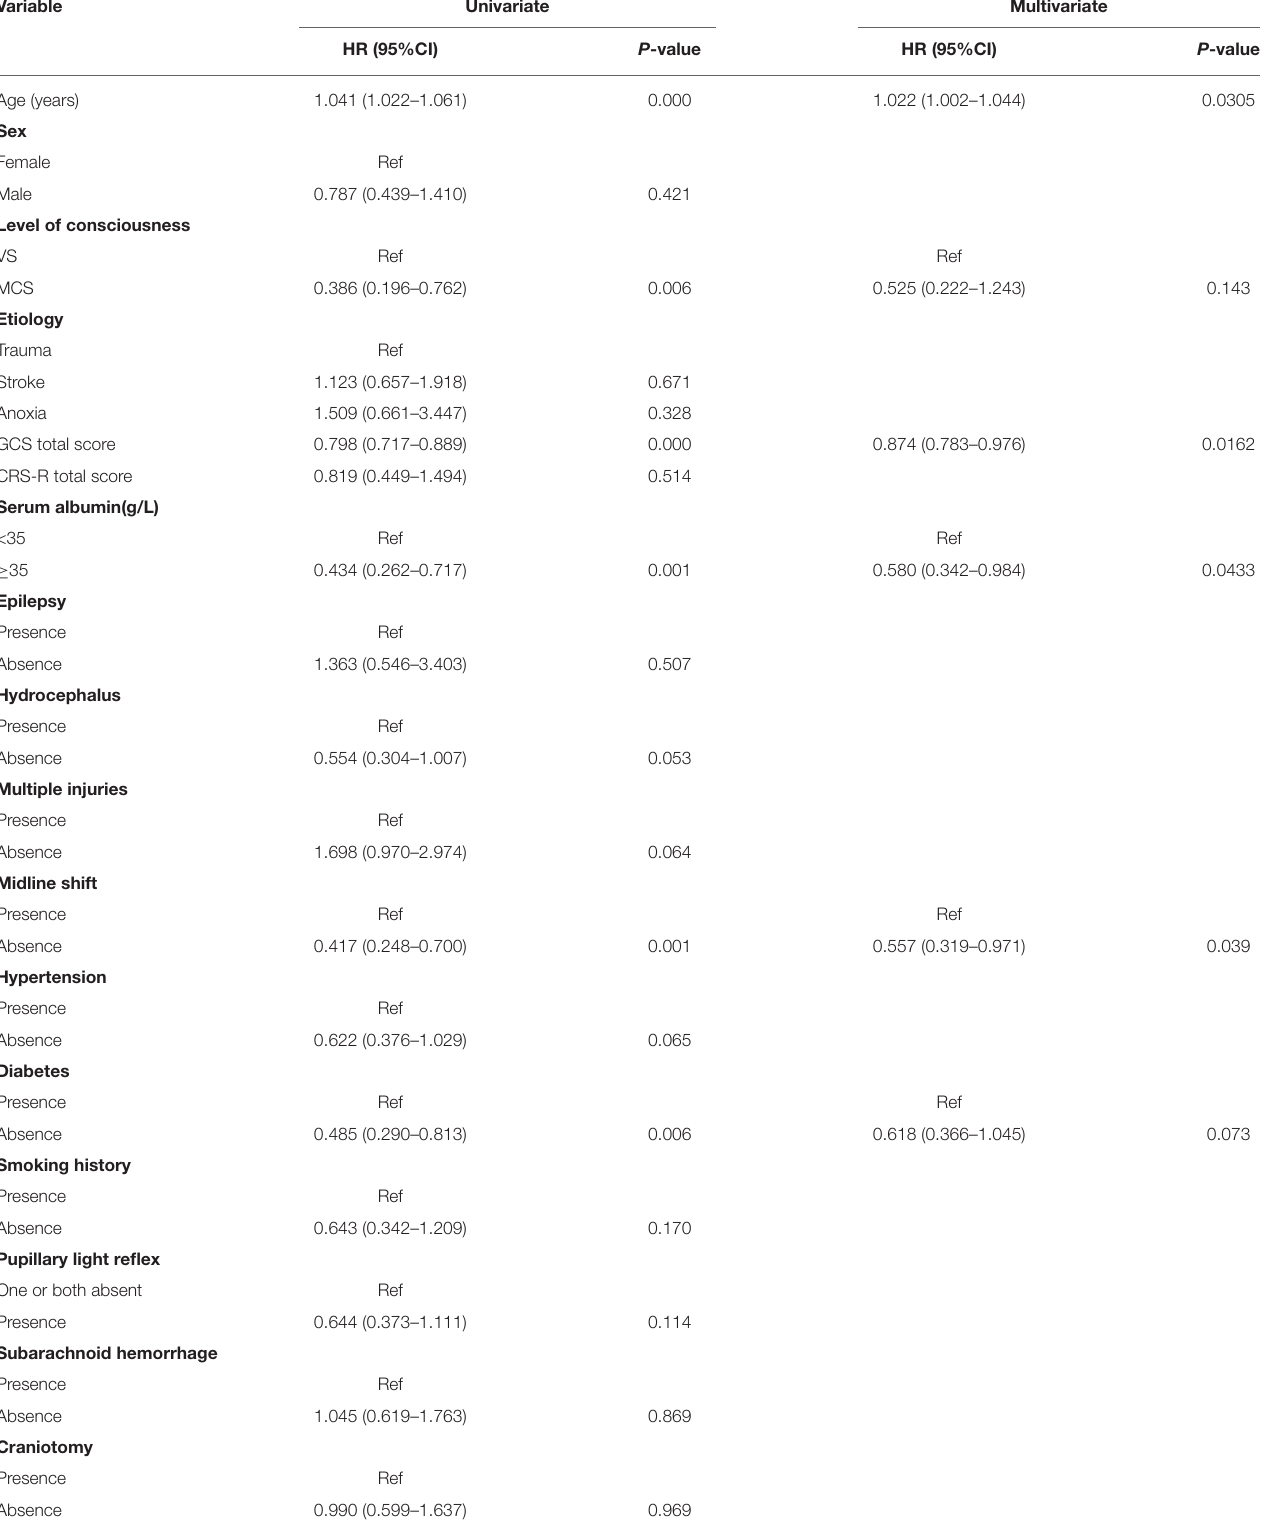
TABLE 2 | Cox regression analyses of prognostic factors in patients with prolonged disorders of consciousness in the training set.